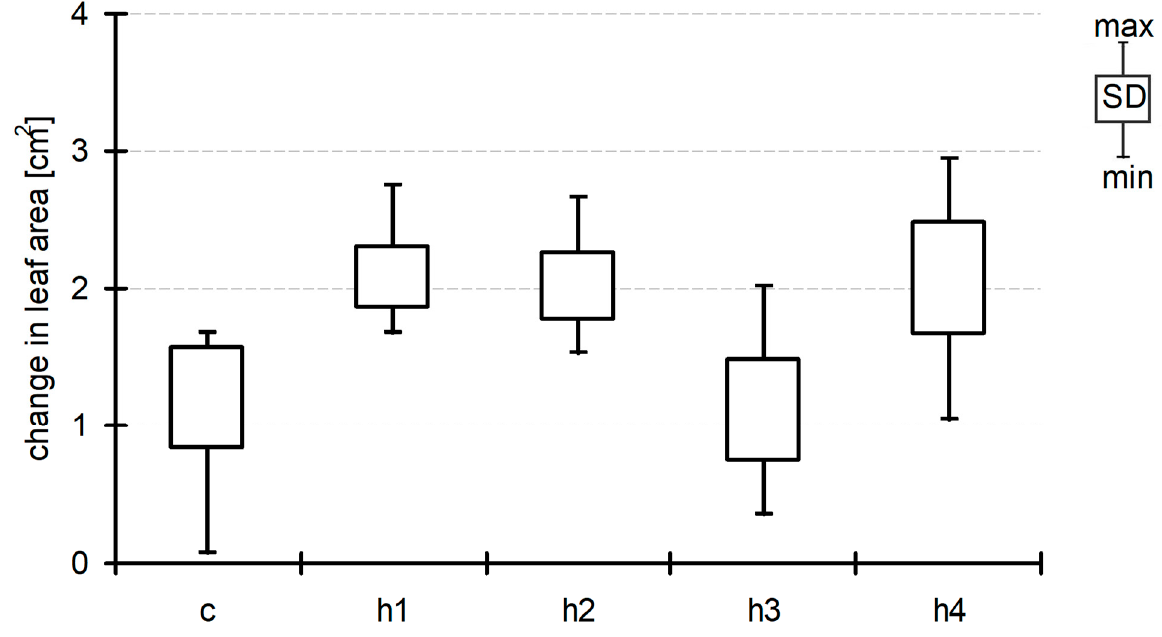
Figure 2. Change in leaf area of Lemna minor between D01 and D07.